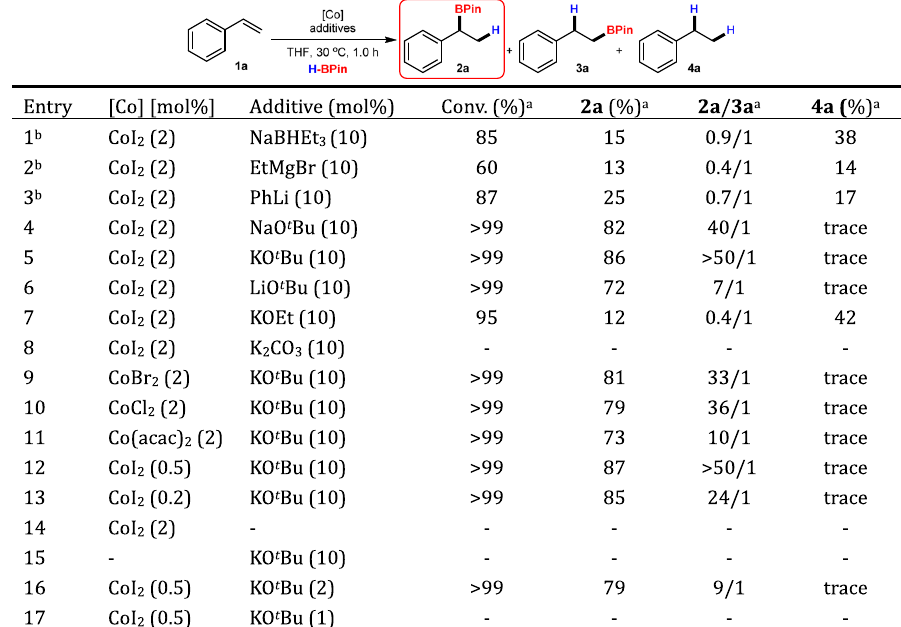
Fig. 2 Optimization of reaction conditions for Cocatalyzed hydroboration of styrene. Reaction conditions: HBPin (0.48 mmol) was added in a portion into a mixture of the cobalt salt, the additive and 1a (0.4 mmol) in anhydrous THF (2 mL), and the resulting mixture was stirred under N 2 at 30 °C for 1.0 h. a Determined by GC analysis of the reaction mixture. b The additive was added in the